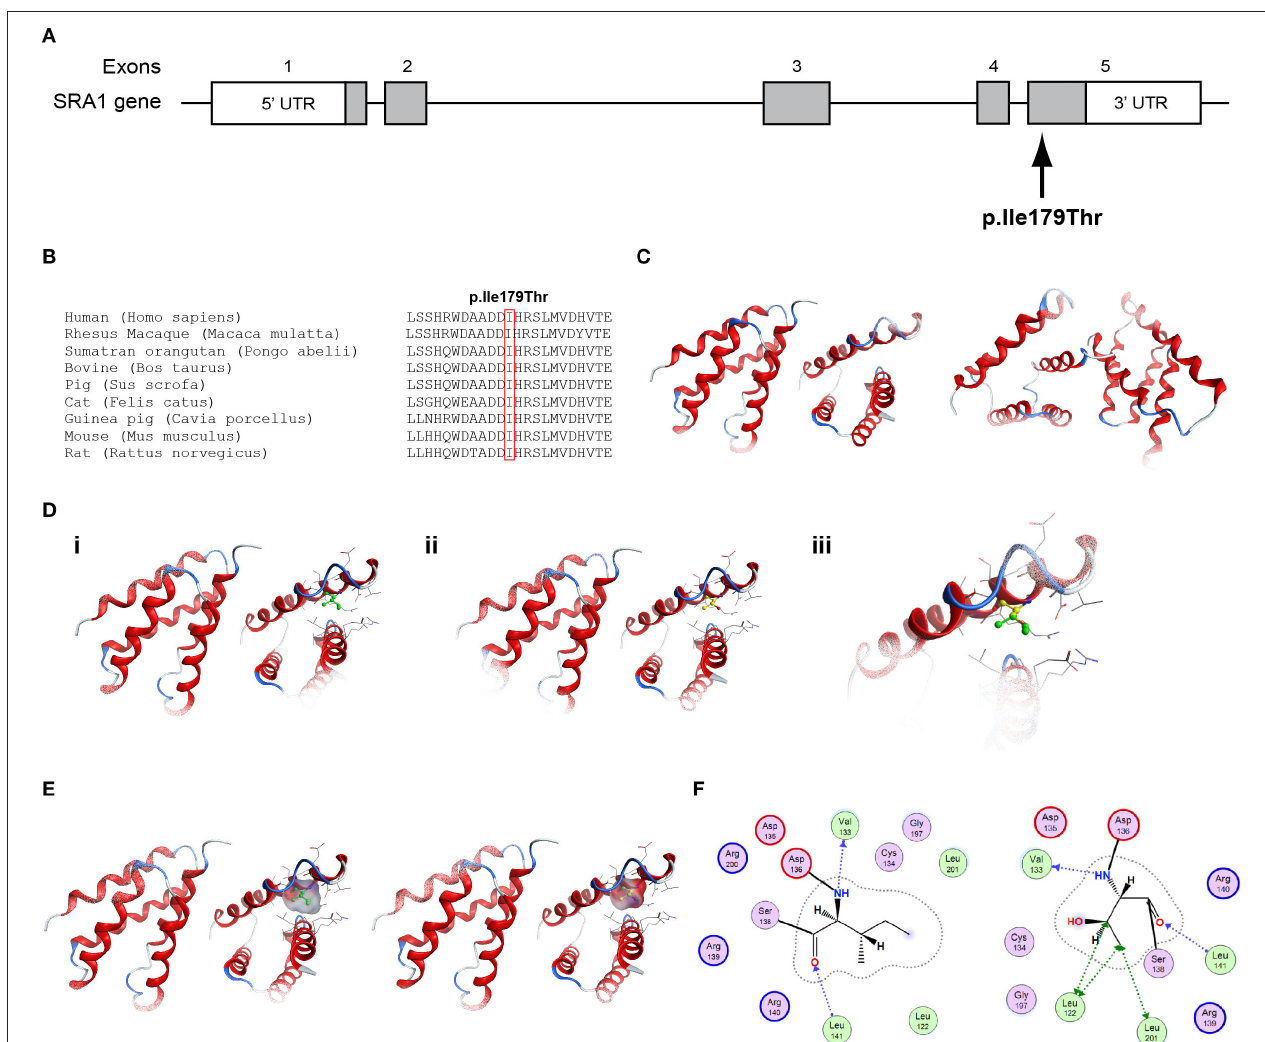
FIGURE 3 | Identification of the p.Ile179Thr SRA1 variant. (A) Schematic representation of the SRA1 gene. The known SRA1 p.Ile179Thr variant identified in a male patient in the heterozygote state and in a female patient in the homozygous state is indicated. (B) Multiple sequence alignment of the amino acid at position 179 of the SRA1 protein from various species. The conserved isoleucine amino acid at position 179 is indicated by red color. (C) The homology model for SRA1. (D) Design of the wild type (i) and mutant model (ii) of SRA1. (iii) Wild type and mutant models superposed. (E) Electrostatic surface calculated and drawn for the wild type and mutant models. (F) 2D interaction diagram for wild type and mutant